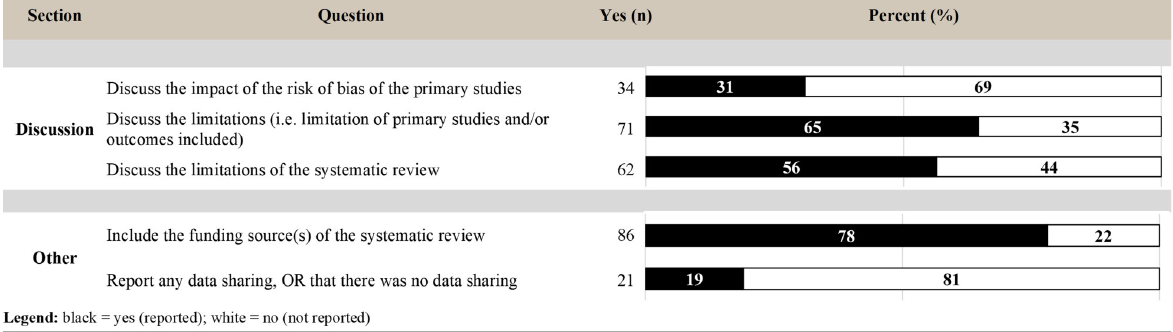
Fig 8. Level of reporting (count and percent) for the items within the discussion and other